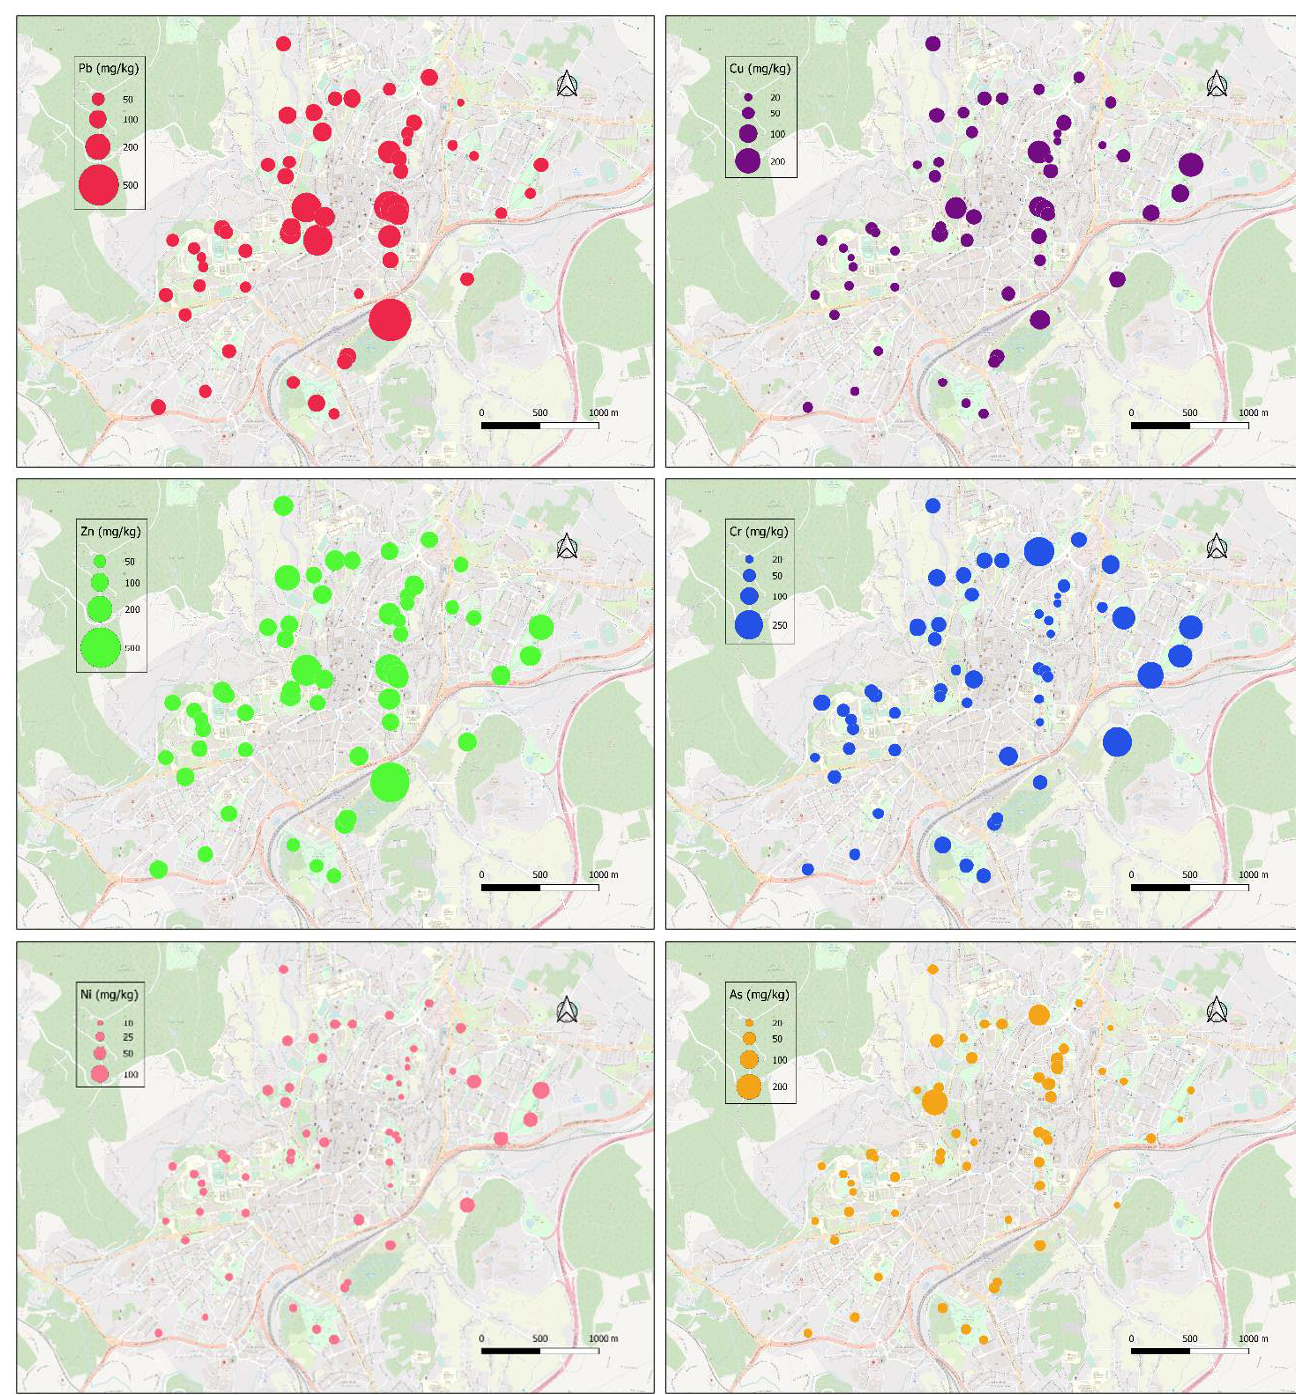
Figure 3. Spatial distribution of trace element concentrations.